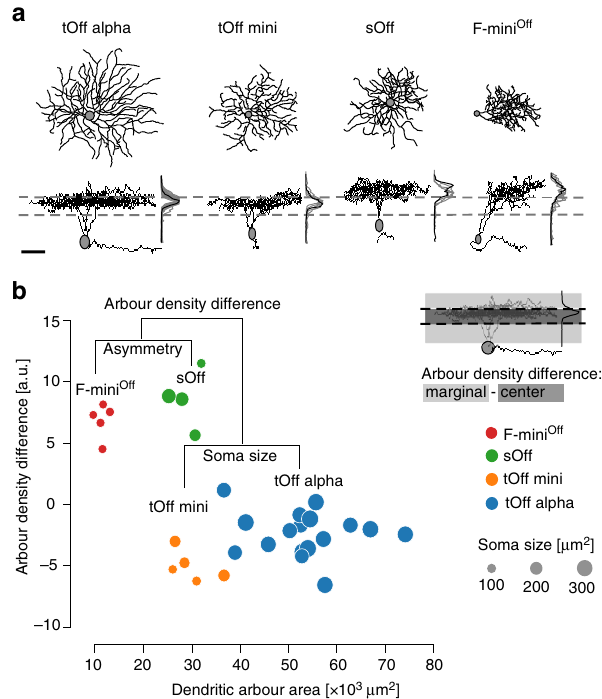
Fig. 2 Anatomical clustering of recorded RGCs. a , Top- and side-views of four reconstructed Off RGCs, one of each studied type, with IPL strati fi cation pro fi les as mean (black) and for all recorded cells of that type (grey). Dashed lines indicate On and Off ChAT bands. b Cluster- dendrogram with the morphological parameters used in each clustering step and the resulting RGC groups: n = 17 tOff alpha, n = 5 tOff mini, n = 4 sOff, and n = 5 F-mini Off . Colours indicate cluster (RGC type), dot diameter represents soma area. Inset: Illustration of arbour density difference measure. Scale bar: a 50 µ m.